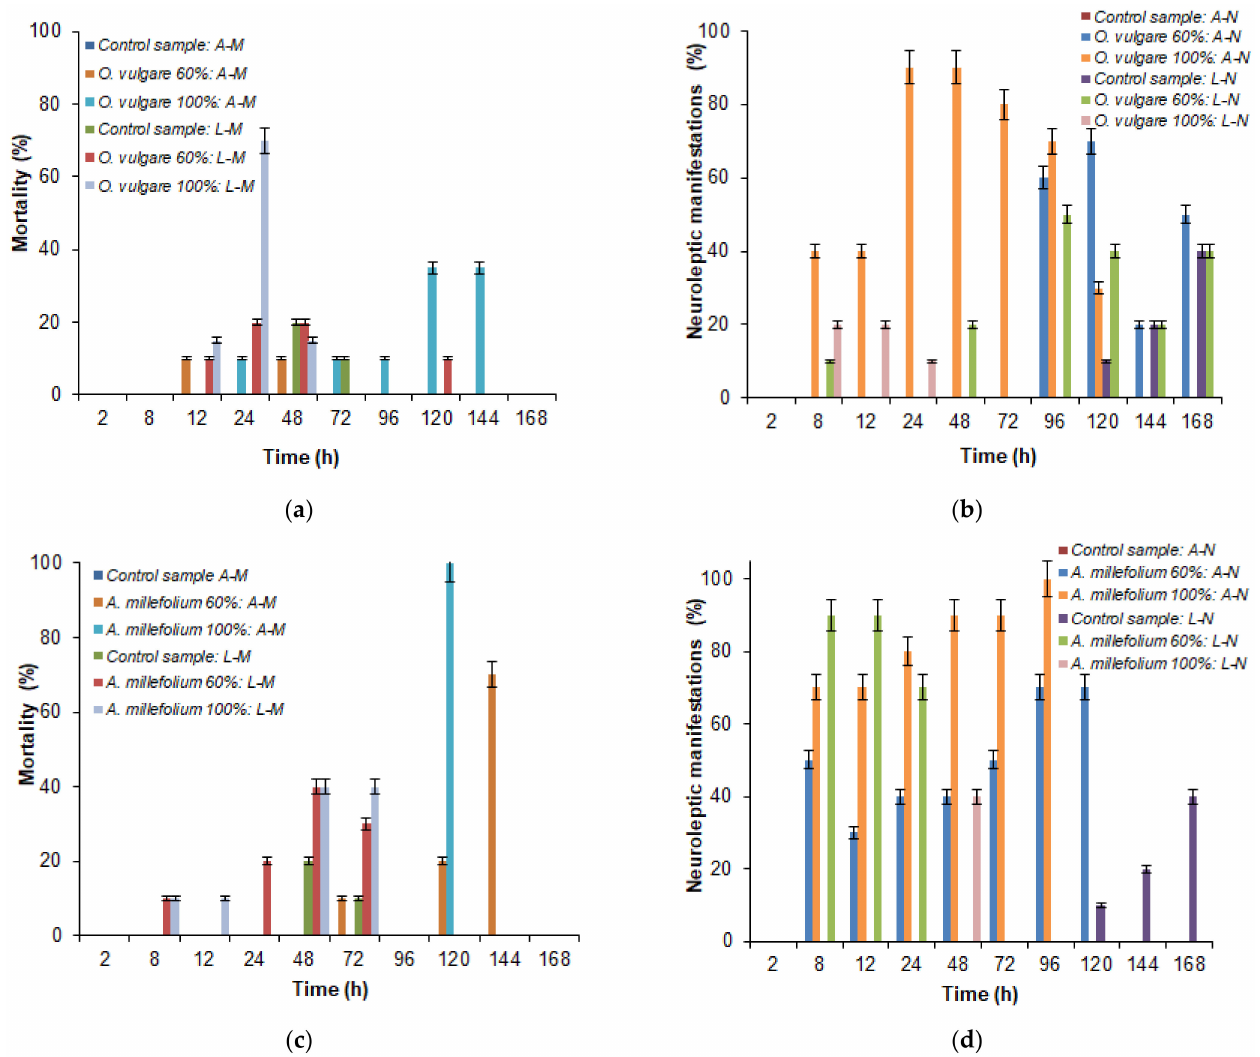
Figure 3. The results of the action of Origanum vulgare ( a , b ) and Achillea millefolium ( c , d ) plant extracts on a population of individuals belonging to Leptinotarsa decemlineata species (adults, larvae) (A-M: adults mortality; L-M: larvae mortality; A-N: adults neuroleptic manifestations; L-N: larvae neuroleptic manifestations). The columns error bars are mean ±